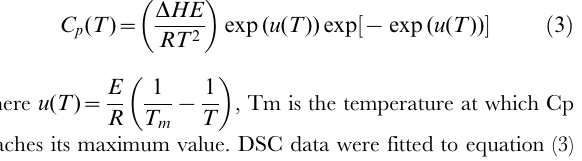
Figure S4 CD spectra of WT Ca MnSODc (A), K184R, L185P Ca MnSODc (B), WT Sc MnSOD (C) and K182R, A183P Sc MnSOD (D) at increased concentrations of GdHCl. The solutions contained 25 mM potassium phosphate (pH 7.4). The measurements were carried out at room temperature. Figure S5 Electrospray-ionization mass spectra of methylated RP-mutant Sc MnSOD (left) and its reconstructed mass distribution profile (right). Ordinate units of intensity are arbitrary and the abscissa units of average molecular mass are in Daltons. The theoretical mass weight of methylated K182R, A183P Sc MnSOD is 23,589 Da. Table S1 Metal contents of WT and RP-mutant Sc MnSOD and